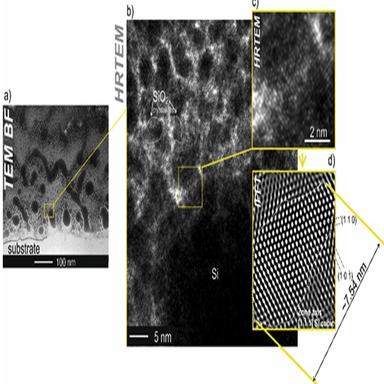
Microstructural characterization of ZONE 1 of the coating by HRTEM: a). TEM BF image within the marked area of the HRTEM analysis; b). HRTEM image of the PTFE + SiO2/silicone interface; c). HRTEM image of the SiO2 nano-crystallite; d). IFFT image of the SiO2 nano-crystallite obtained from the 'c)' image by the application of a twin-oval mask.